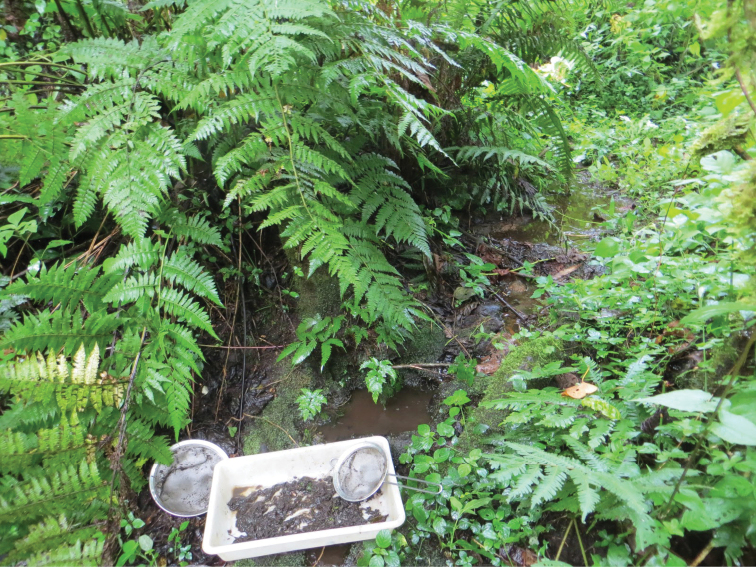
Small forest stream at 1900 m in remaining fragment of afromontane cloud forest on Vuria, the highest mountain in the Taita Hills, Taita-Taveta district, northeastern part of Eastern Arc Mountains, Kenya. Albeit minute, the small pools seen in the photo were inhabited by tens of individuals of Agabus
ruwenzoricus. January 19, 2016.